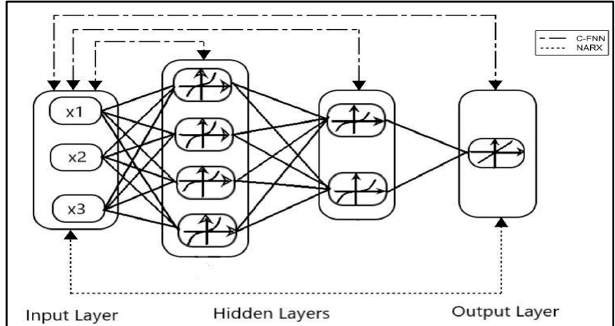
Figure 7. Basic architecture of MLP [35] along with the architecture of NARX [36] and C-FNN